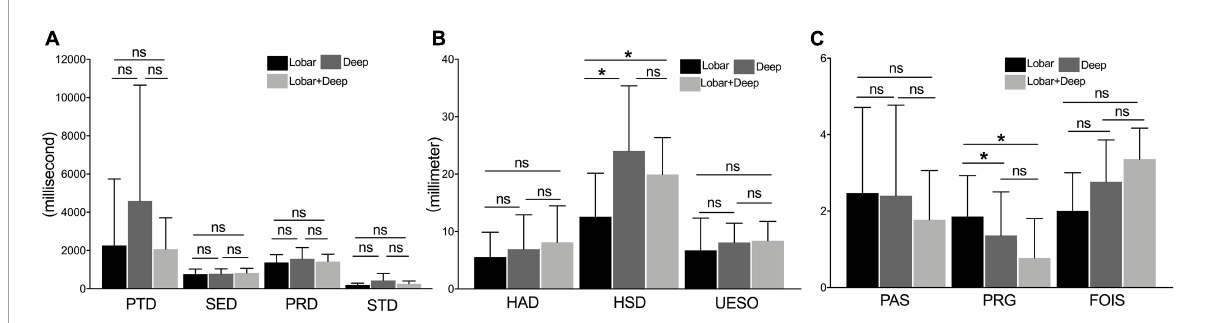
FIGURE5 The comparison of measures among lobar, deep intracerebral, and lobar + deep intracerebral stroke subgroup. (A) Measures of duration (including PTD, SED, PRD, and STD) under the VFSS examination. (B) Measures of motion (including HAD, HSD, and UESO) under the VFSS examination. (C) Measures of pharyngeal function (including PAS, PRG, and FOIS) under the VFSS. PAS, Penetration-Aspiration Scale; FOIS, Functional Oral Intake Scale; PRG, Pharyngeal Residual Grade; PTD, pharyngeal transit duration; HAD, hyoid bone anterior-horizontal displacement; HSD, hyoid bone superior-horizontal displacement; SED, soft palate elevation duration; PRD, pharyngeal response duration; STD, stage transition duration; UESO, upper esophageal sphincter opening. * p < 0.05; ns, not significant.